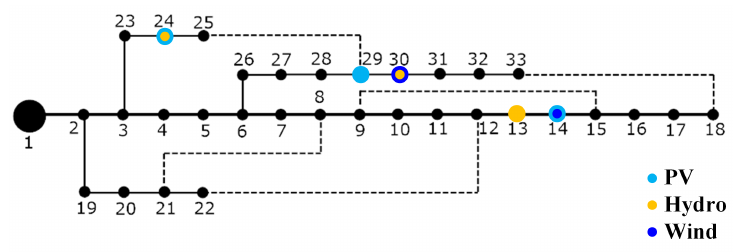
Figure 2. Electricalbus